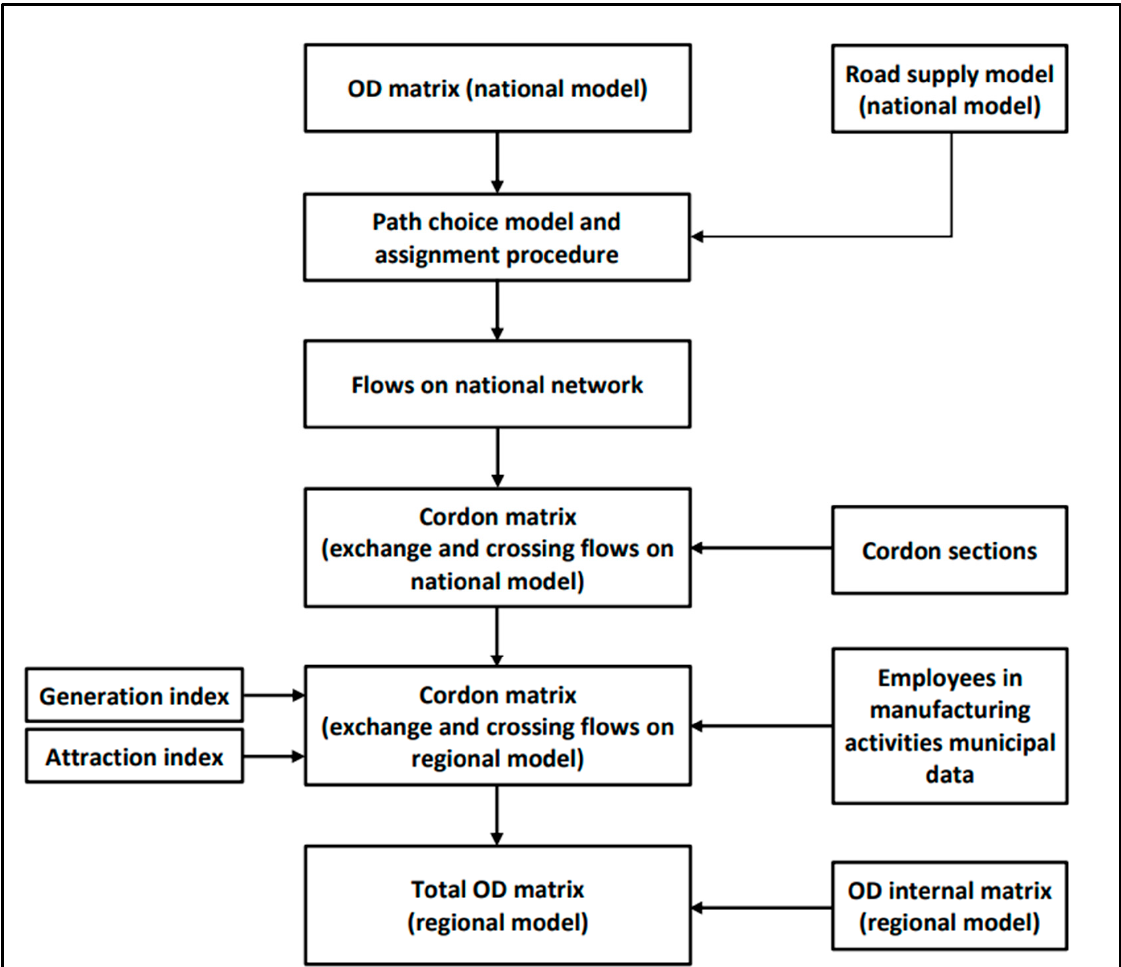
Figure 3. Procedure—Phase 2: regional OD total matrix.